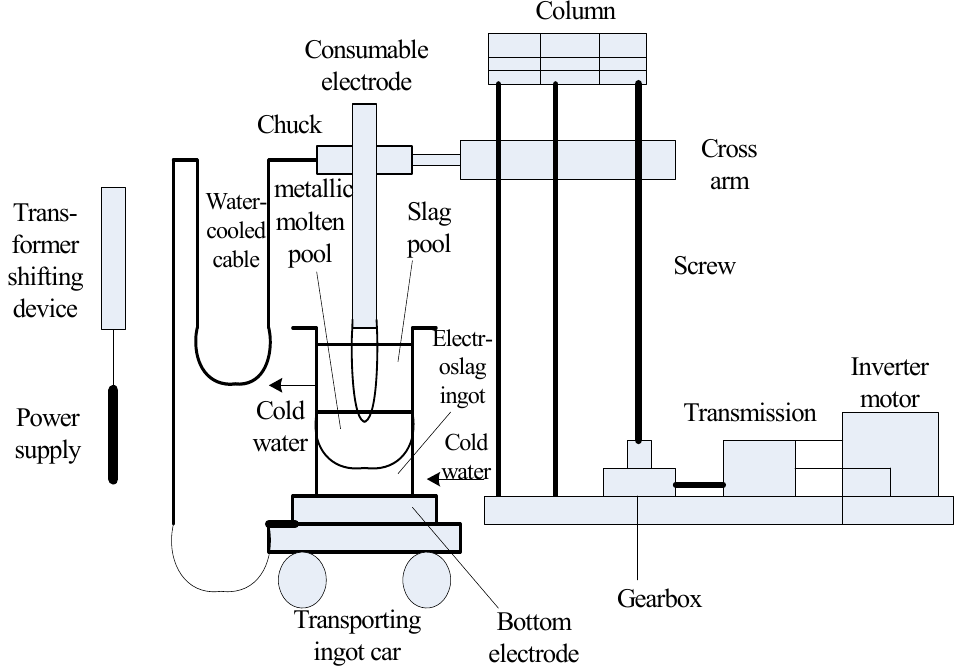
Figure 1. Technique flowchart of the ESR